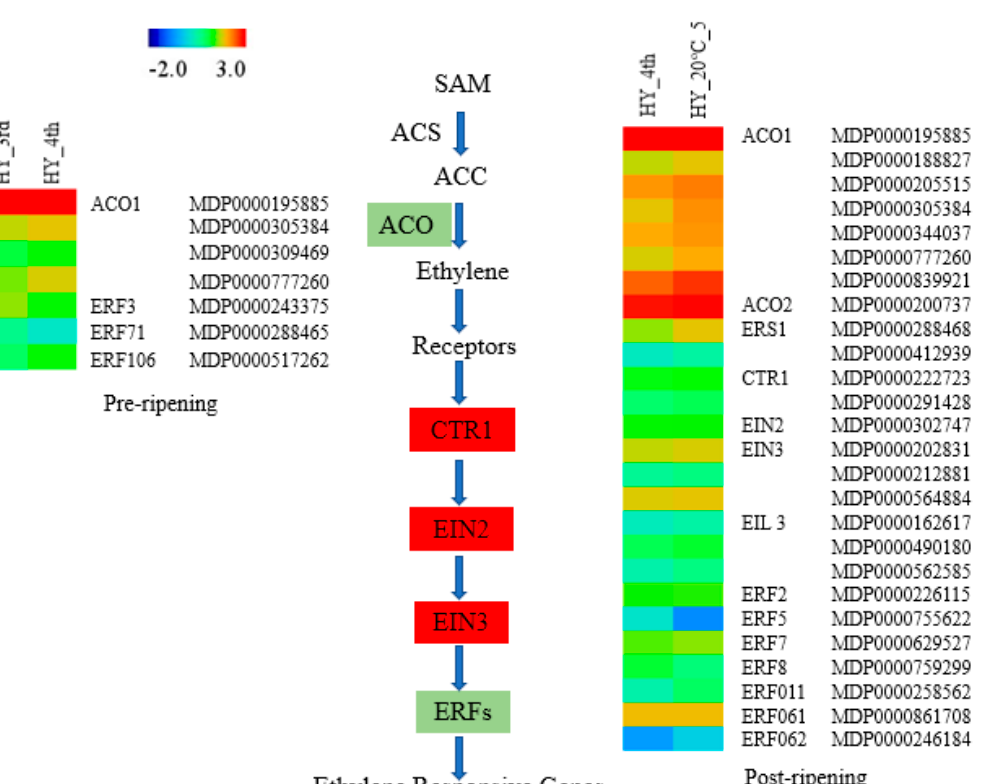
Figure 6. Heat map represents DEGs involved in ethylene signaling pathway in pre (HY_4th vs. HY_3rd) and post (HY_20 °C_5 vs. HY_4th) ripening groups. Genes remarked with light green color denotes expression in both groups and red color denotes expressed in the post-ripening group only. ACS (1-Aminocyclopropane-1-carboxylic acid synthase); ACO (1-Aminocyclopropane-1-carboxylic acid oxidase); ERS (Ethylene response sensor); CTR1 (CONSTITUTIVE TRIPLE RESPONSE 1); EIN2 (ETHYLENE INSENSITIVE 2); EIN3 (ETHYLENE INSENSITIVE 3); EIL3 (ETHYLENE INSENSITIVE 3-like 3); and ERFs (Ethylene Response Factors).